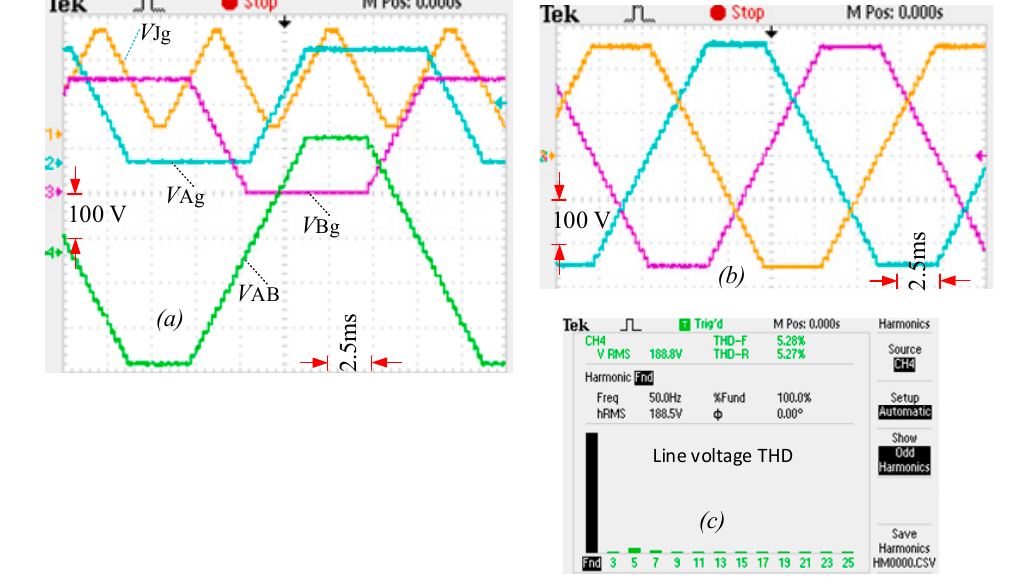
Figure 10. Experimental results, ( a ) Junction voltage, pole voltages ( V Ag , V Bg ), line voltage ( V AB ); ( b ) 29-level 3-phase line voltages; ( c ) THD of the line voltage, when CHB cells are fed by trinary related dc power supplies. Reprint with permission [4261051118814]; 2018, IEEE.